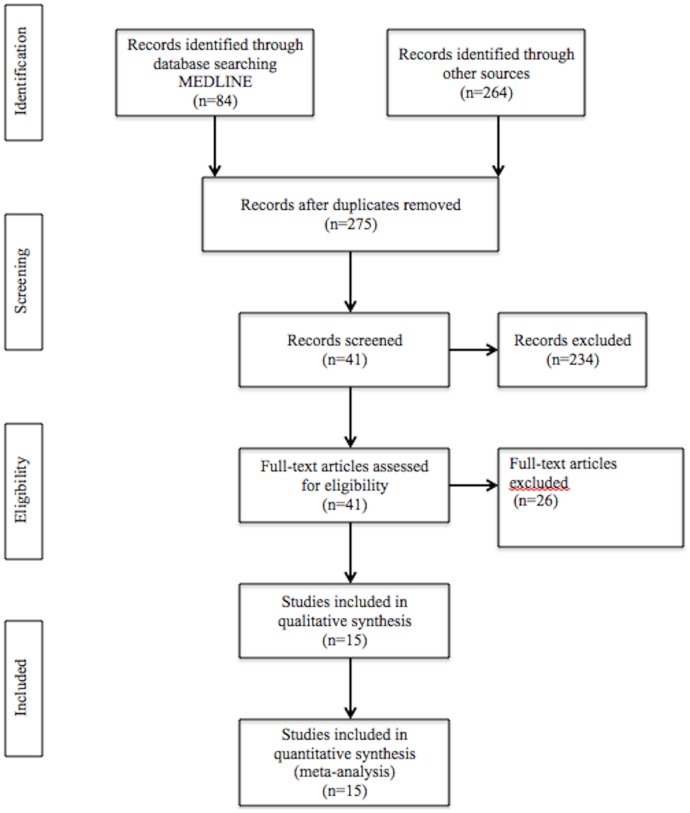
PRISMA Flowchart of the search strategy.